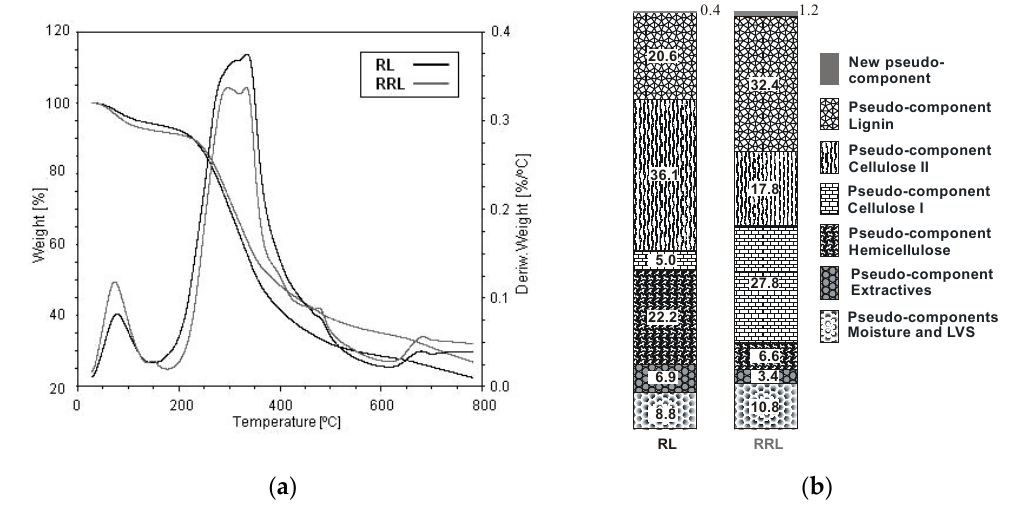
Figure 8. TGA and DTG curves ( a ) along with the results of deconvolution of the DTG curve ( b ) of RL and RRL samples.